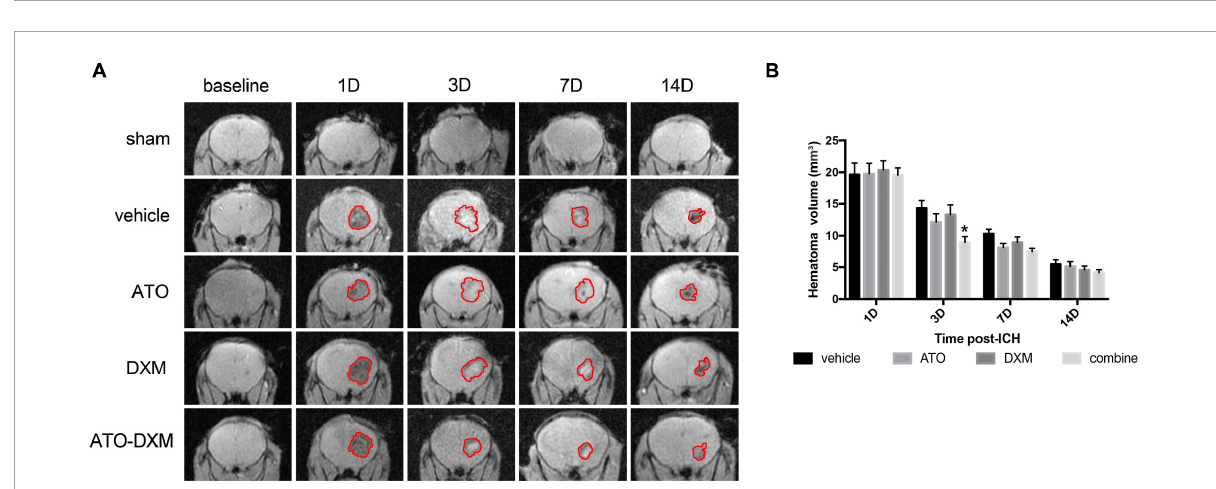
FIGURE4 Dynamic changes in hematoma volumes were estimated by 3D-GRE MRI. (A) Representative 3D-GRE MRI images (coronal sections) at baseline and 1, 3, 7, and 14 days after ICH. The areas circled in red indicate the hematoma. (B) Quantification of total hematoma volume at baseline, 1, 3, 7, and 14 days after ICH. * p < 0.05 vs vehicle